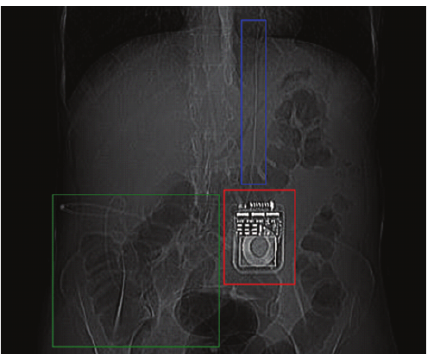
Figure 1: A preinsufflation “scout” view from the patient’s CT colonography. Red box: the occipital nerve stimulator generator; blue box: wire from occipital nerve stimulator generator; and green box: course of lumboperitoneal